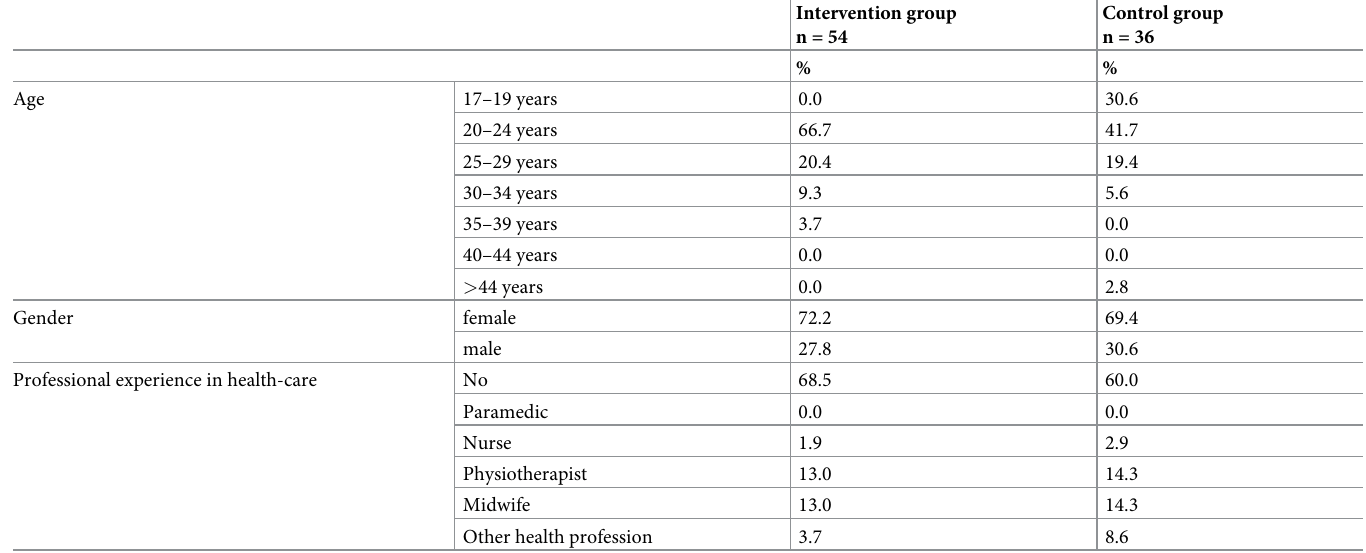
Table 1. Sociodemographic data as a percentage of the sample.